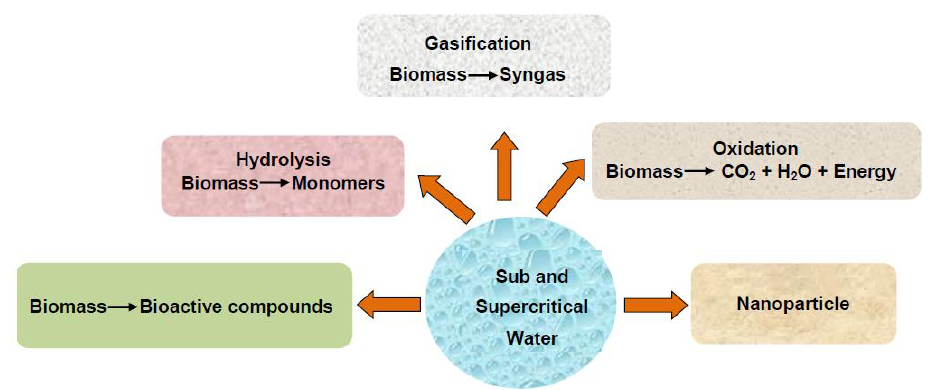
Figure 4. Main sub and supercritical water applications.